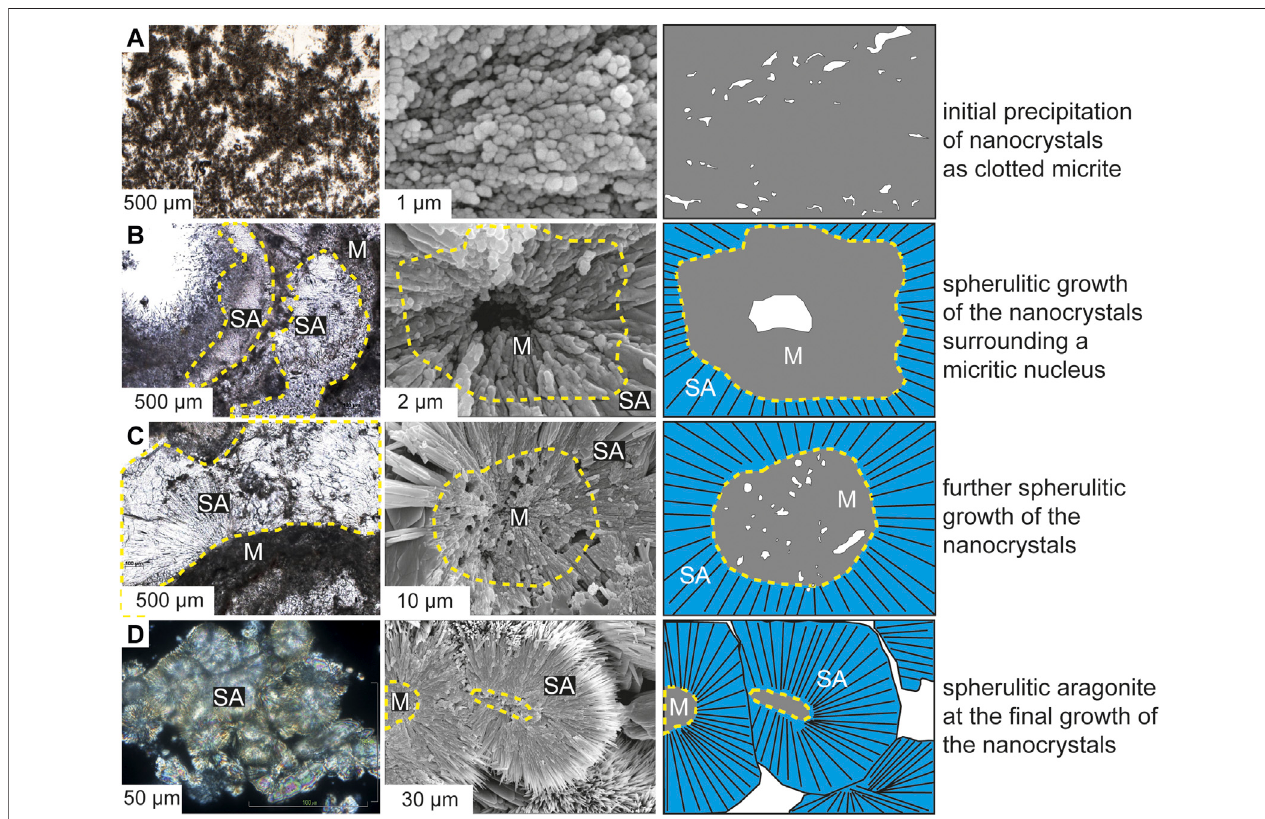
FIGURE 7 | Micro-scaled features of calcitic clotted peloidal micrite and botryoidal and spherulitic aragonite in Bagni San Filippo travertines showing thin section image (left) , SEM image (middle) and sketch (right) . M-micrite, SA-spherulitic aragonite. In (A) , the calcitic clotted peloidal micrite consisting of nanocrystals and forming most of the travertine fabrics. In (B) , aragonite fi bers forming botryoidal and spherulitic structuresnucleate on micritic substrate. The spherulite nucleus consists of a pore space with aragonitic nanocrystals with a radial fi brous arrangement grading outward into the fi brous crystals. In (C) , in the thin section photo on the left the contact between the calcitic micritic travertine and the fi brous aragonite crystal fans is sharp; under SEM, aragonite fi bers, in a closely spaced radial arrangement, appear gradually transitional into aragonitic nanocrystals forming a porous framework at the nucleus. In (D) , aragonite spherulites form aggregated structures; under SEM spherulites consist of fi brous aragonite crystals with reduced to absent nanocrystals at the nuclei.